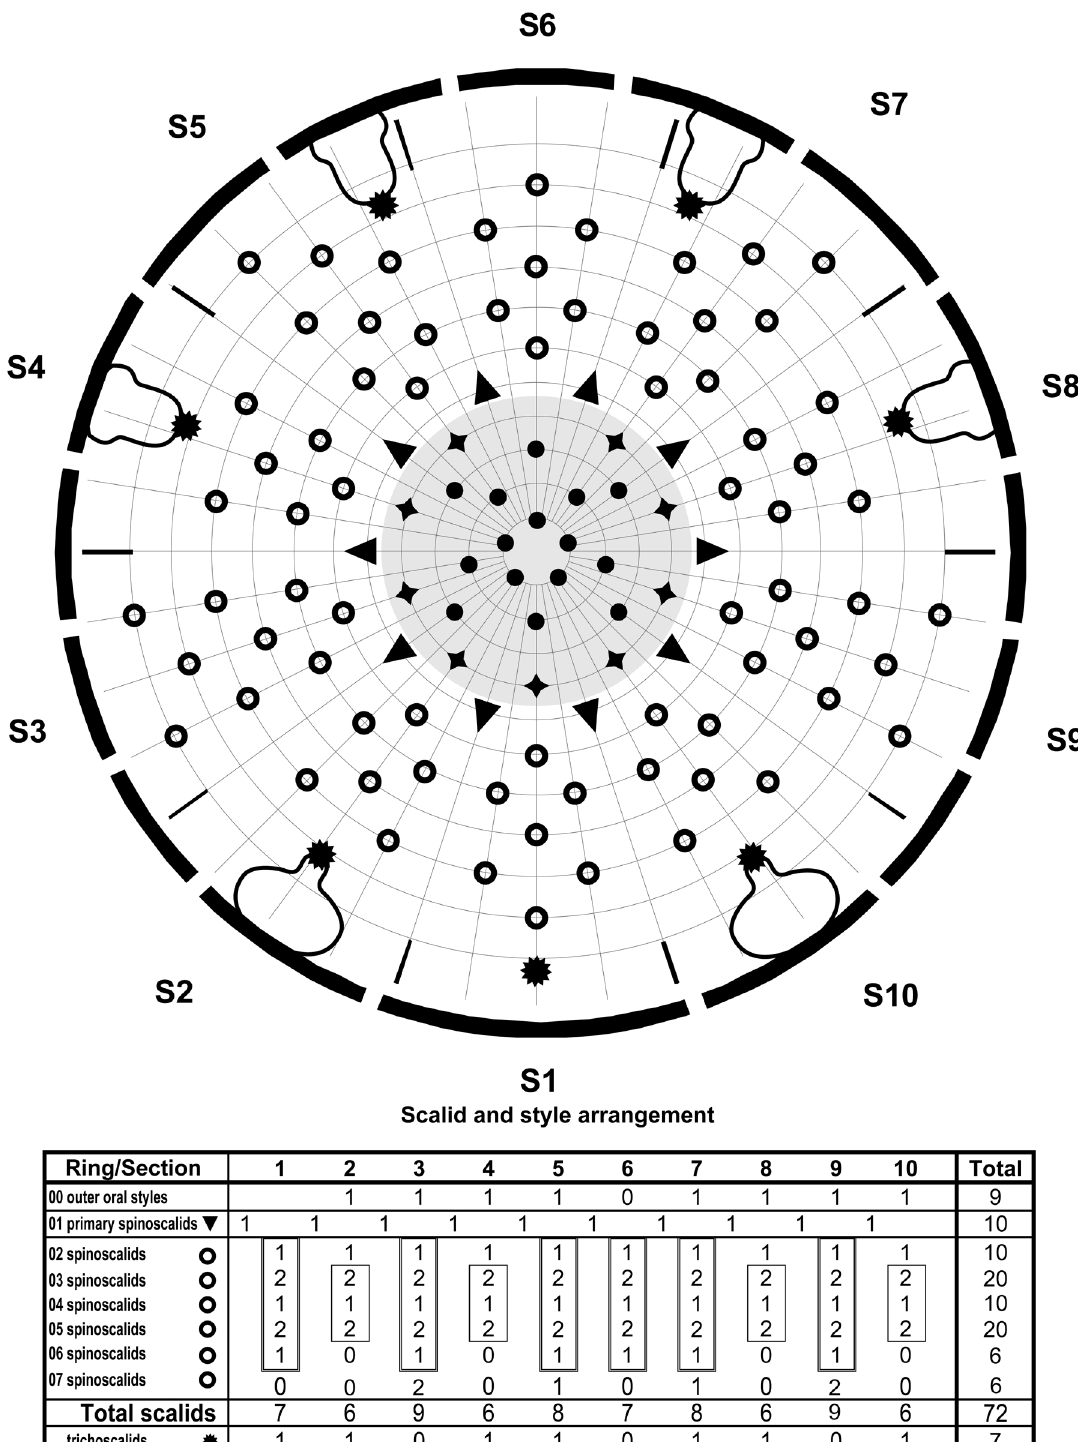
Fig. 13. Diagram of mouth cone (grey area), introvert and placids in Echinoderes sensibilis Adrianov et al ., 2002, showing distribution of inner oral styles (full circles), outer oral styles (diamonds), primary scalids (triangles), spinoscalids (thick open circles) and trichoscalids (stars), with positions of trichoscalid plates and placids indicated. Table shows the scalid arrangement by sector; single-lined boxes mark quincunxes, double-lined boxes mark ‘double